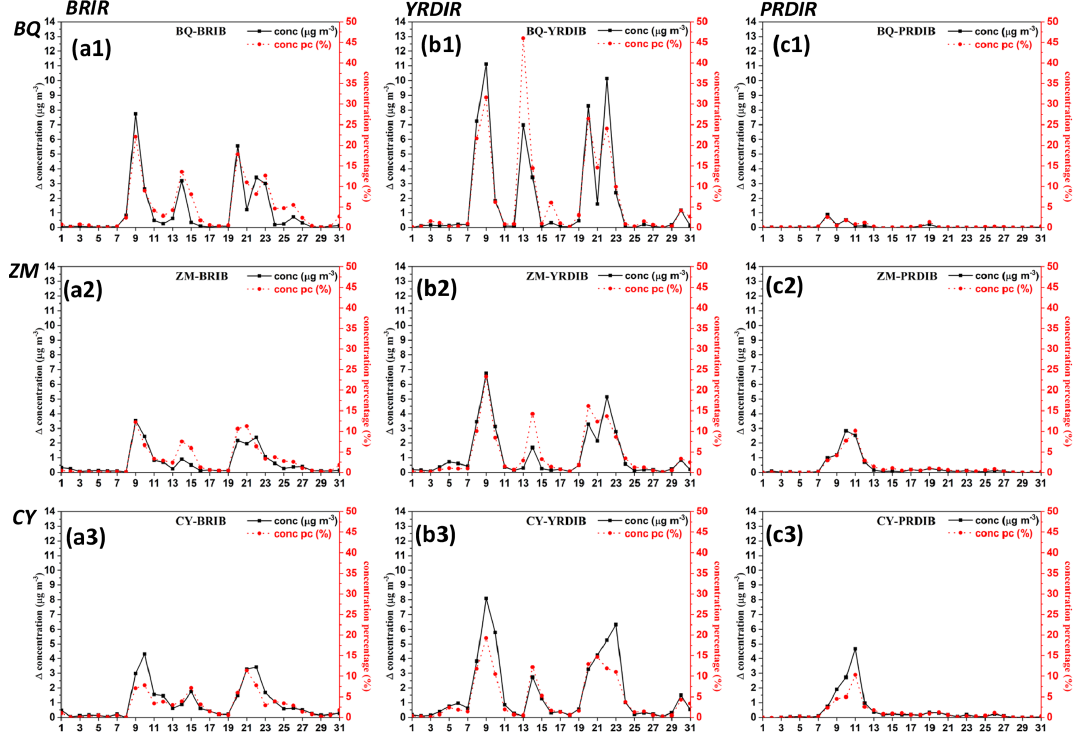
Figure 3. The daily average impact of PM 2 . 5 from BRIR, YRDIR, and PRDIR on air quality stations in Taiwan in January 2017. Panels (1) , (2) , and (3) denote the impact on BQ, ZM, and CY from BRIR (a) , YRDIR (b) , and PRDIR (c) , respectively. The impact was calculated with the BFM method, i.e., the difference between the base and zero-out